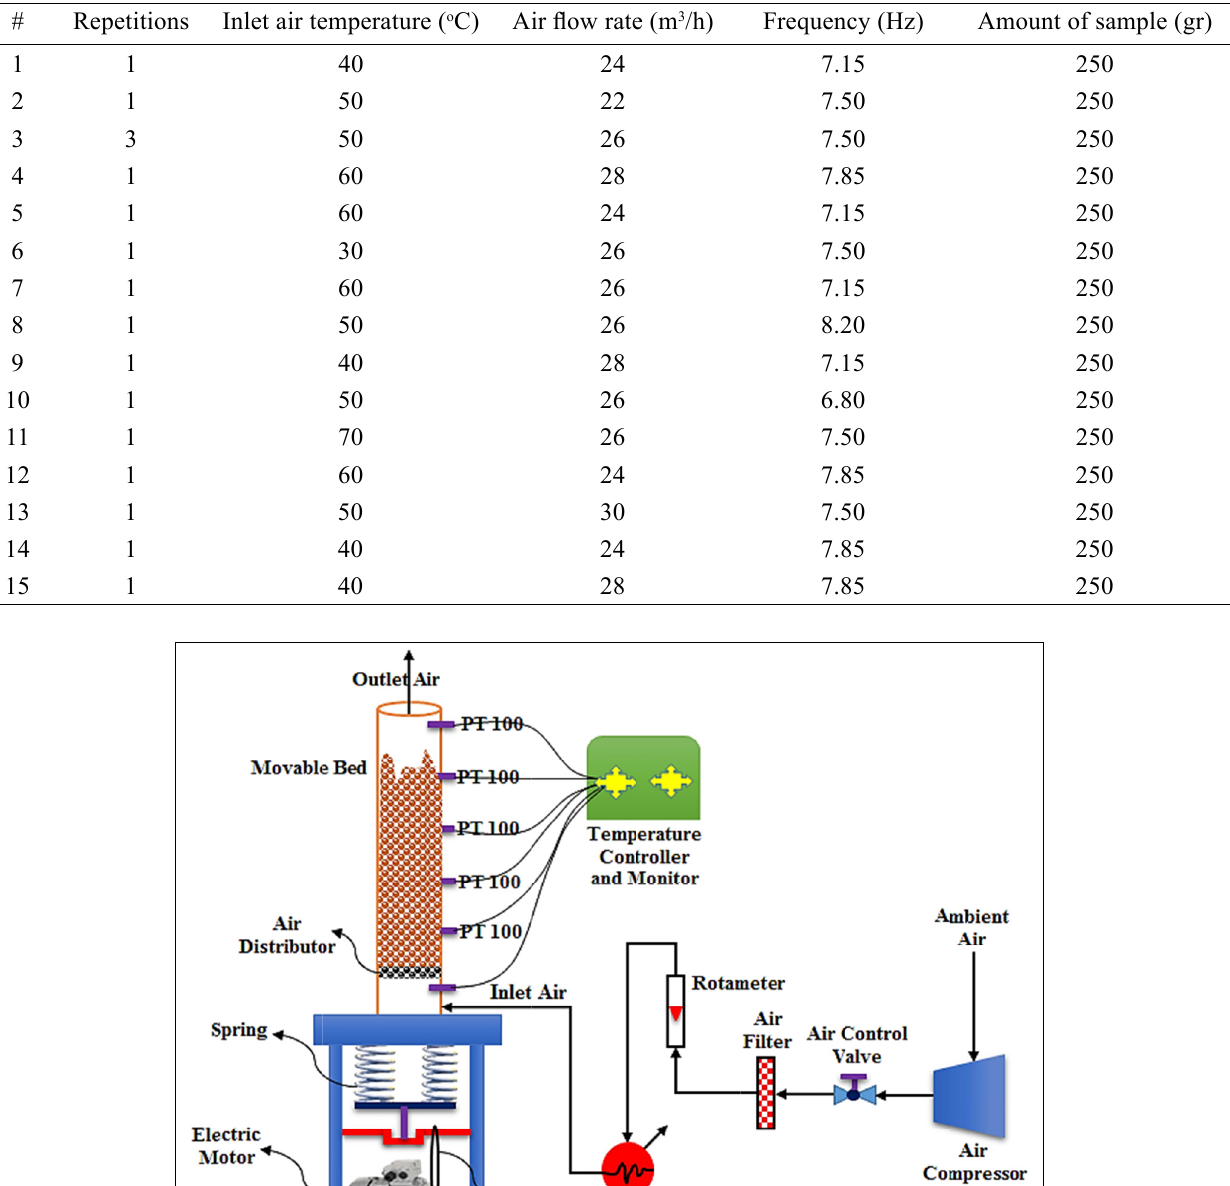
Table 2. Experimental design of hawthorn drying process in the fluidized bed dryer Experiment # Repetitions